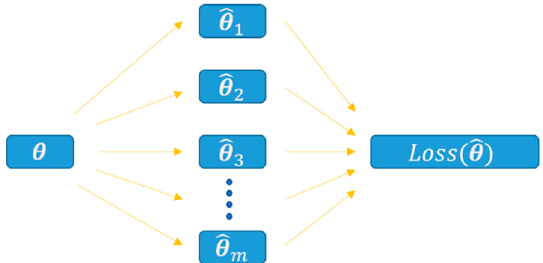
Figure 3. Diagram of the new loss function that leverage all subordinate losses, where θ denotes the parameter of the main network and θ 1 , θ 2 , θ 3 , . . . , θ m denote the parameters of the subordinate networks.